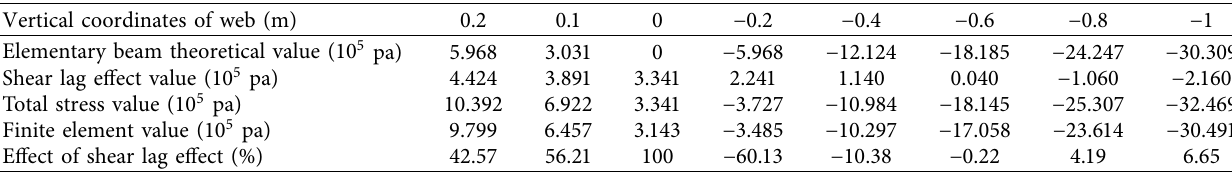
� 12 m; L � L � 6m) (concentrated load). 1 2 3